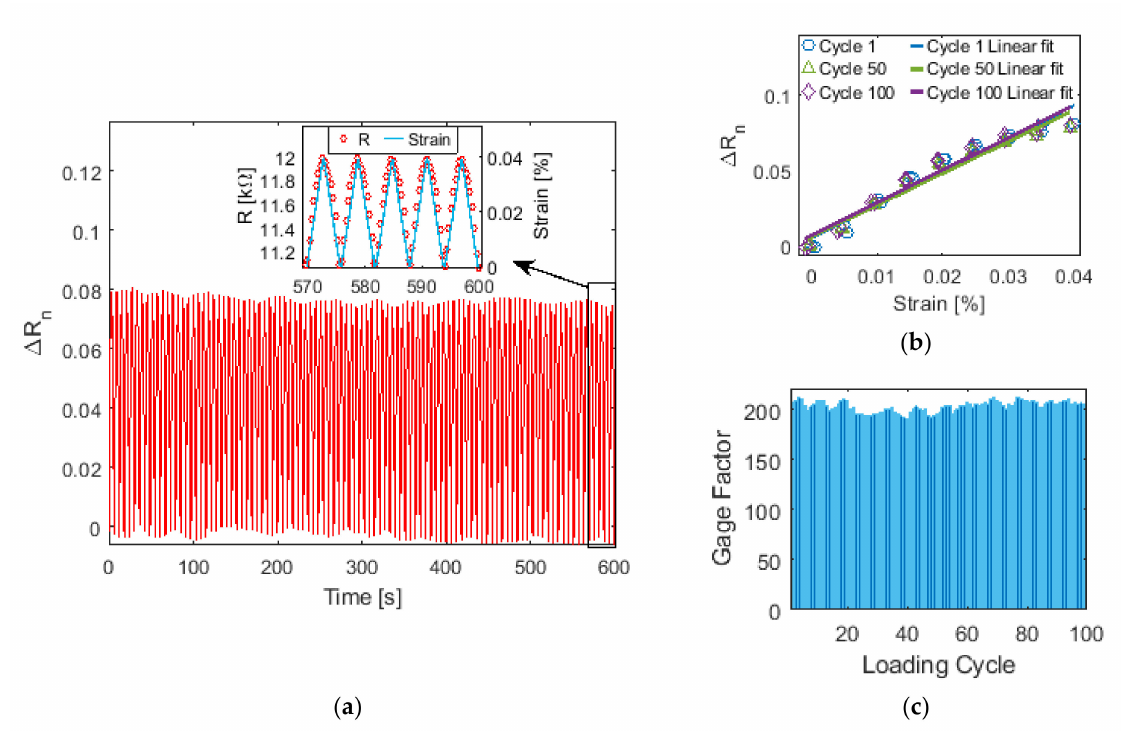
Figure 7. ( a ) The normalized electrical resistance time history of a nanocomposite thin film subjected to 100 tension cycles are plotted. The inset shows the response for the last five loading cycles and is overlaid with the applied strains. ( b ) Sensor hysteresis was examined by considering the resistance change for three different loading cycles with respect to the applied strains. ( c ) The gage factor for each of the 100 loading cycles are